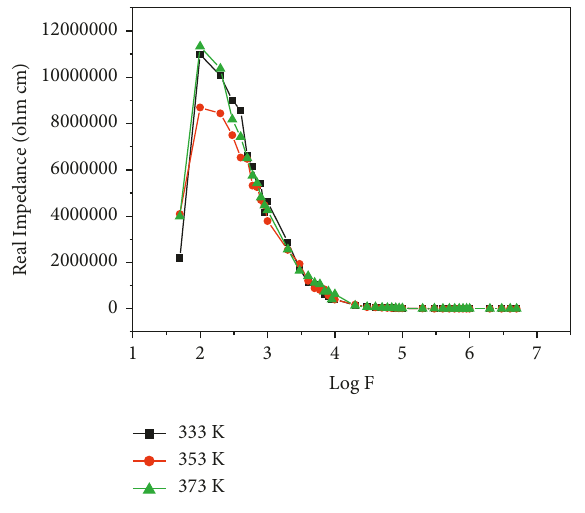
Figure 7: Real impedance vs log